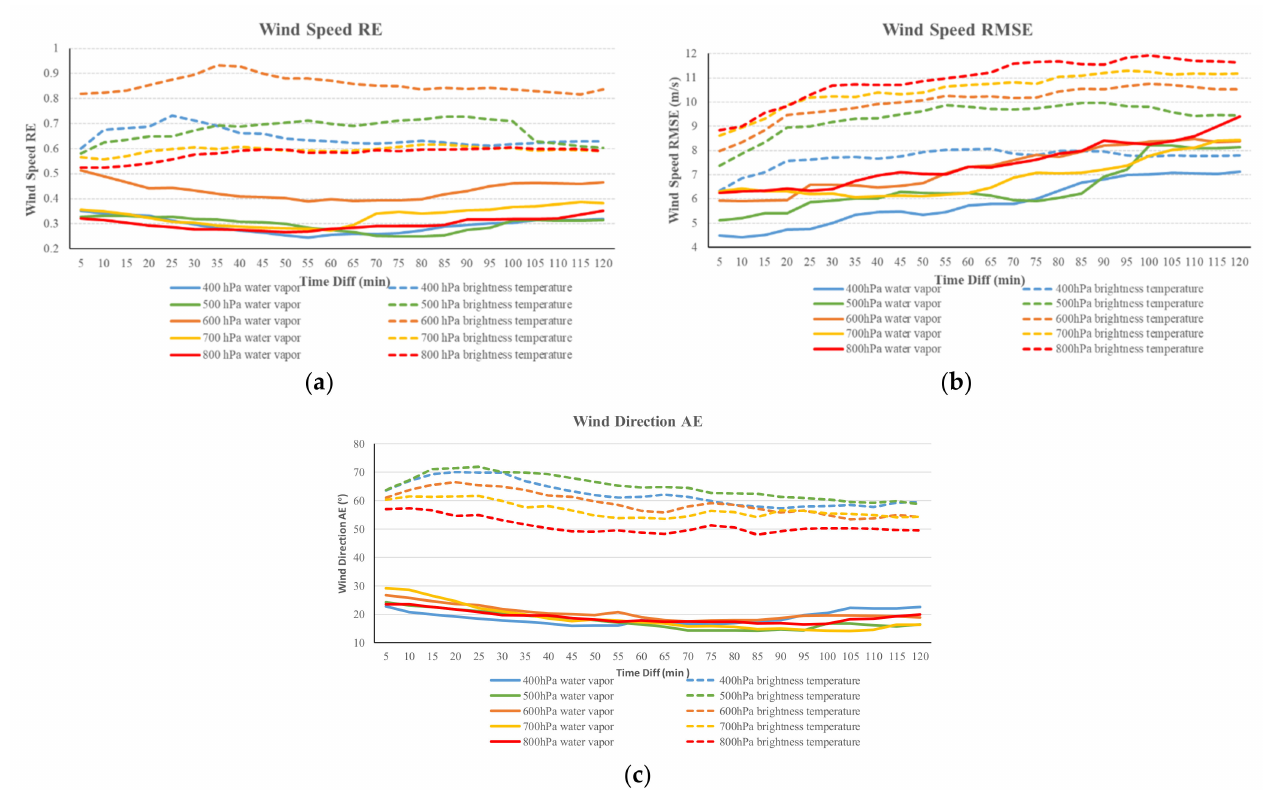
Figure 13. Wind speed RE ( a ), wind speed RMSE ( b ), and wind direction AE ( c ) at different heights and time intervals by using water vapor and brightness